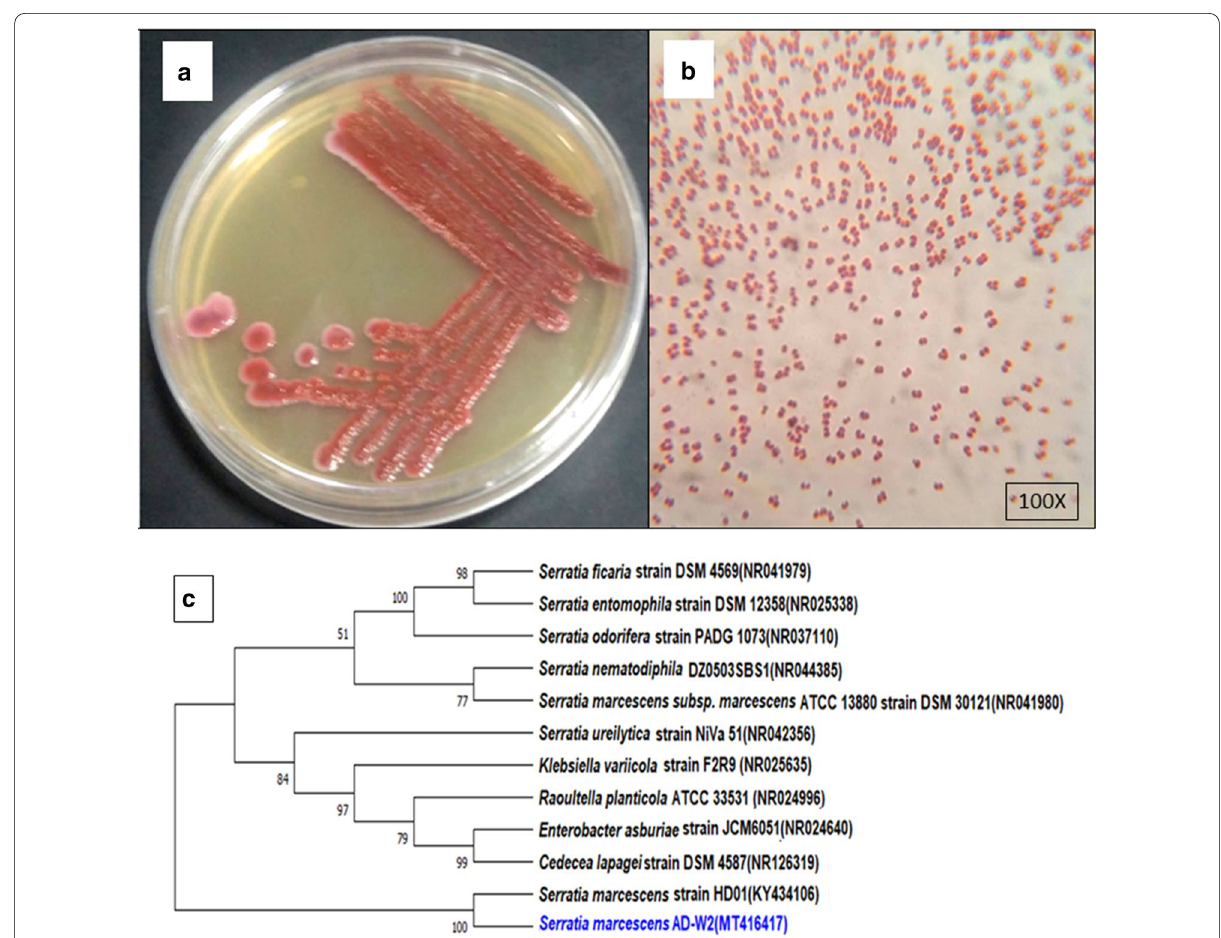
Fig. 1 a Morphology of pure isolate AD-W2 on Nutrient Agar plate. b Microscopic image of pure isolate AD-W2 after Gram staining. c Phylogenetic tree of AD-W2 with closely related 16S rRNA gene sequences of Type strains